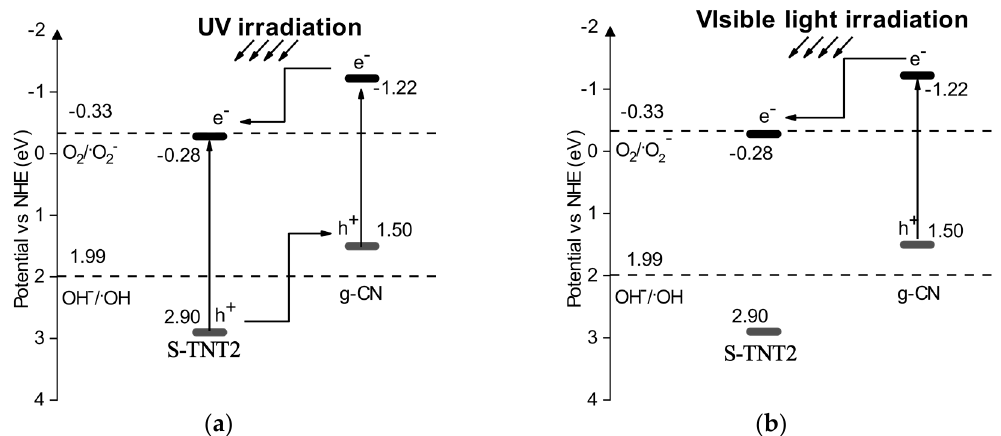
Figure 7. Proposed schematic of NO removal mechanism for the as-prepared S-TNT/g-CN composites, S-TNT2 under ( a ) UV irradiance and ( b ) visible light.